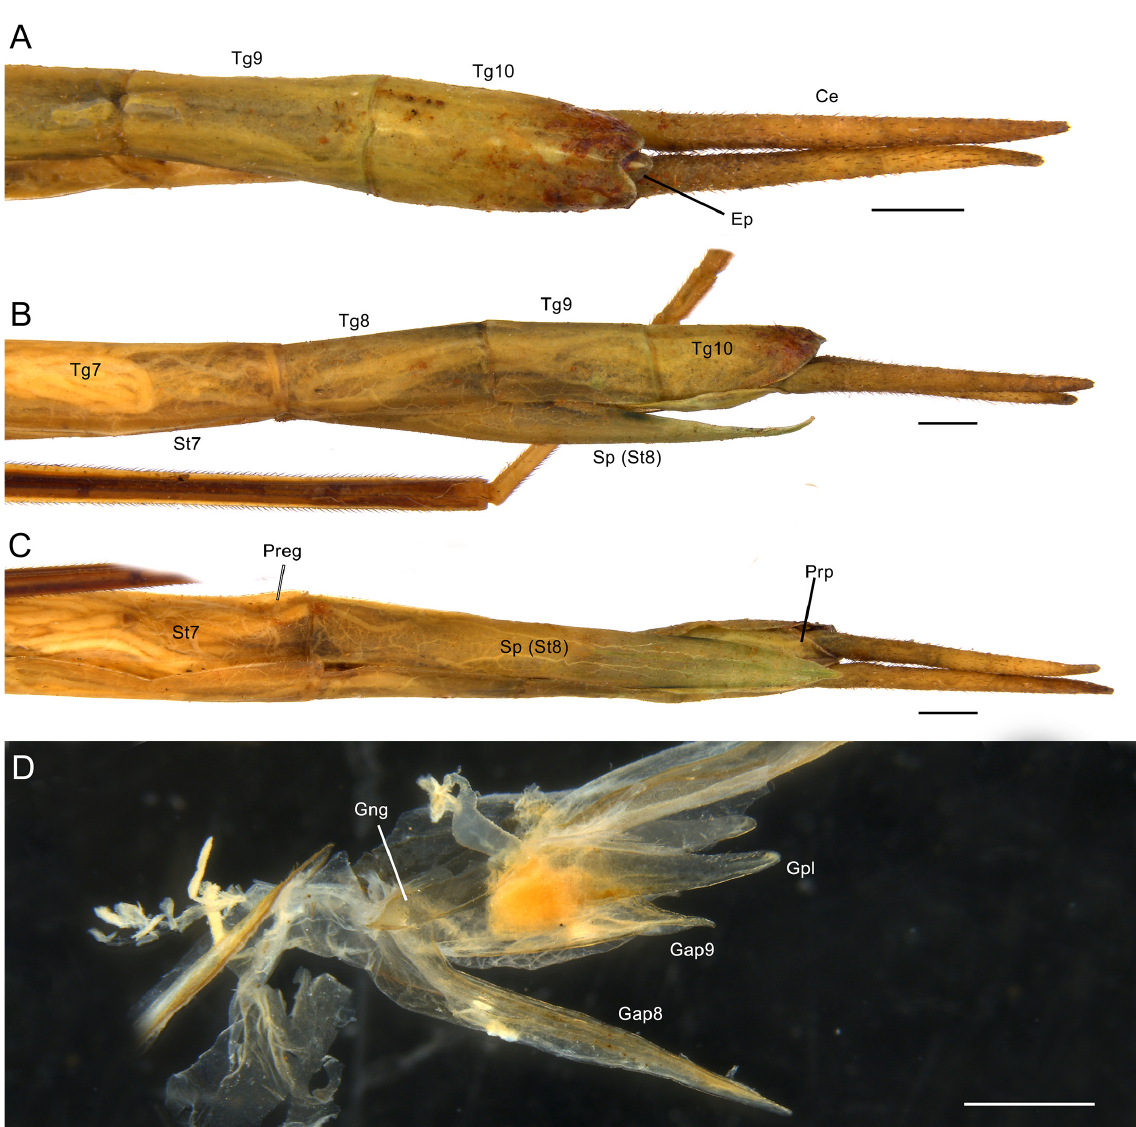
Fig. 17. Arumatia anyami Ghirotto, Crispino & Neves gen. et sp. nov., terminalia morphology. A–C . Holotype, ♀ (MZUSP 1091). D . Paratype (MZUSP 1320). A . Dorsal view. B . Lateral